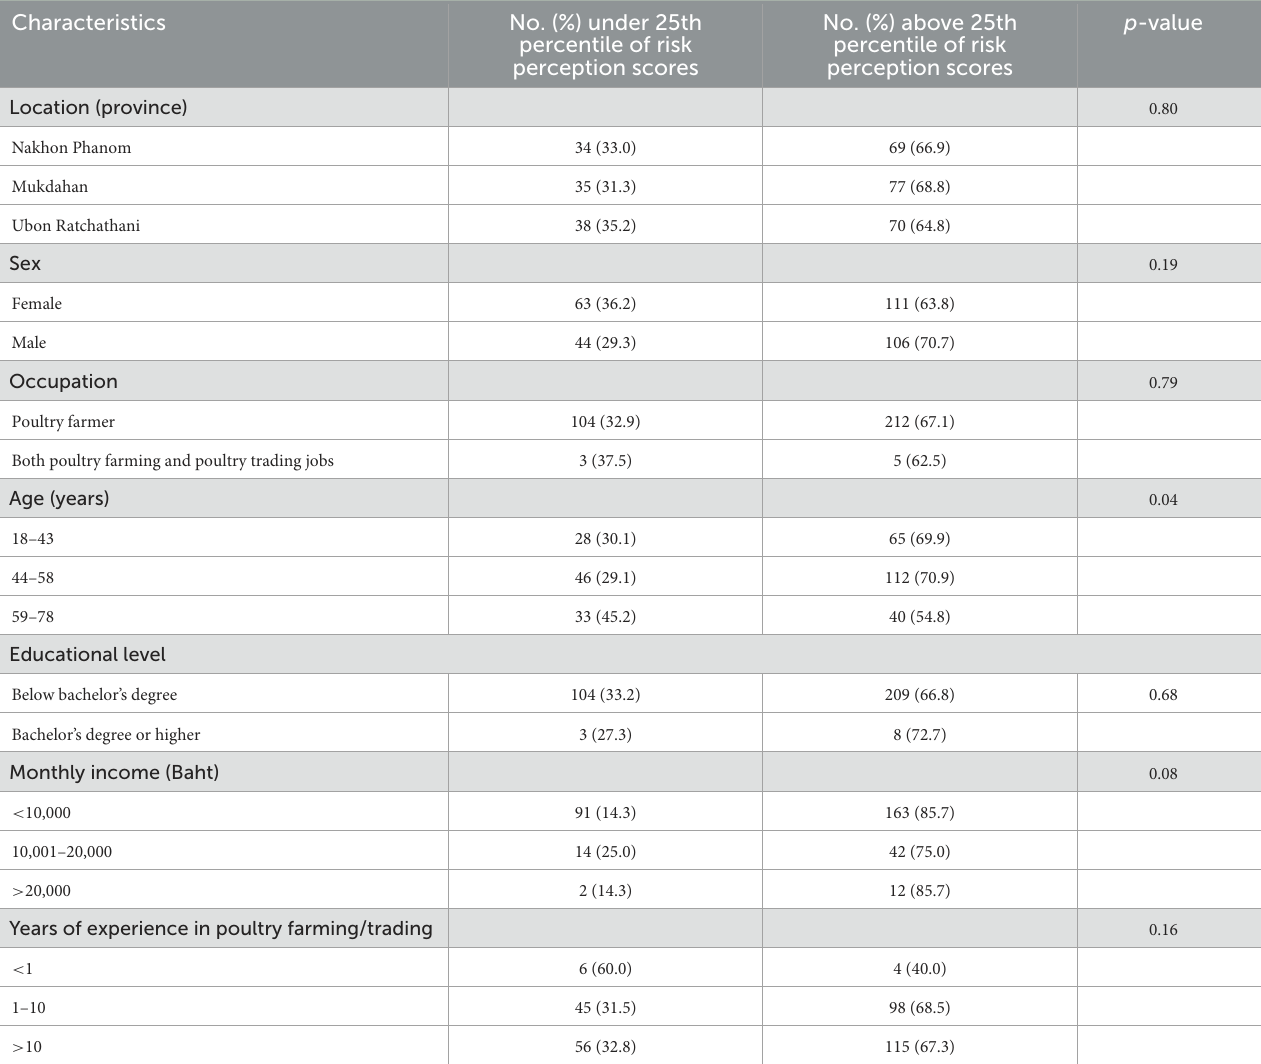
TABLE 2 Risk perception scores on avian influenza by participant characteristics among live-poultry traders and farmers along border areas in three provinces of Thailand.